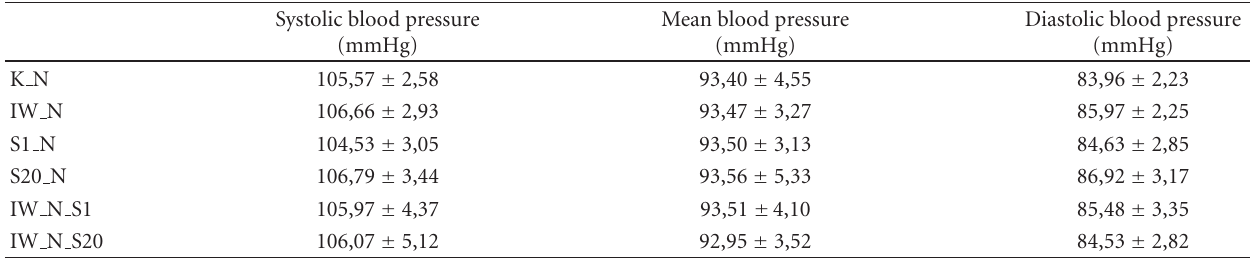
Mean blood pressure (mmHg)